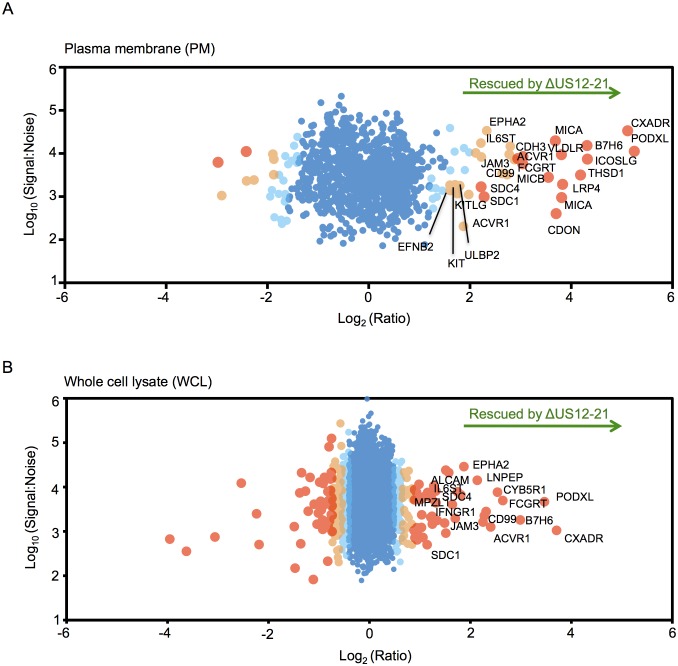
The US12 family targets numerous plasma membrane proteins.Cells infected with HCMV (Merlin) or HCMV △US12-21 mutant were processed to give PM or WCL fractions and analyzed by TMT mass spectrometry. Scatter plot of proteins identified in the PM (panel A) or WCL fractions (panel B) respectively and quantified by 2 or more unique peptides. Fold change (△US12-21-infected fibroblasts/HCMV-infected cells) is shown as the log2 ratio on the x-axis and the signal:noise on the y-axis as log10. Proteins unaltered by the US21-21 deletion locate at the center of the plots (0 log2/1 fold-change), whereas proteins to the left or right of center represent proteins down- or up-regulated by the US12-21 deletion respectively. Significance B was used to estimate p values (Cox et al., 2009). The 2 different alleles of MICA present in HFs were detected by this analysis.